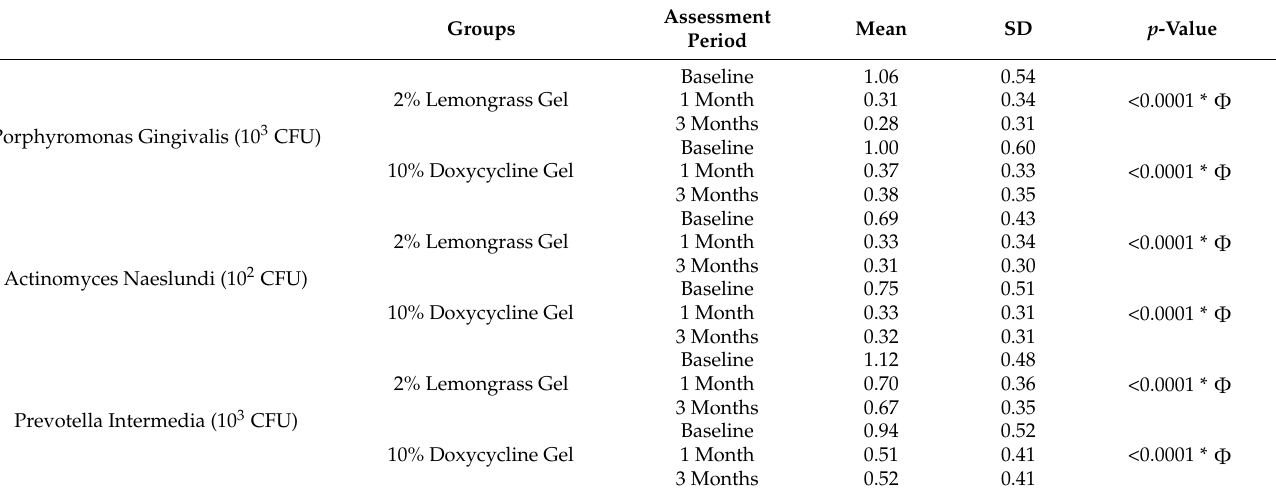
Table 1. Comparison of mean scores of both clinical and microbiological parameters at baseline. Groups